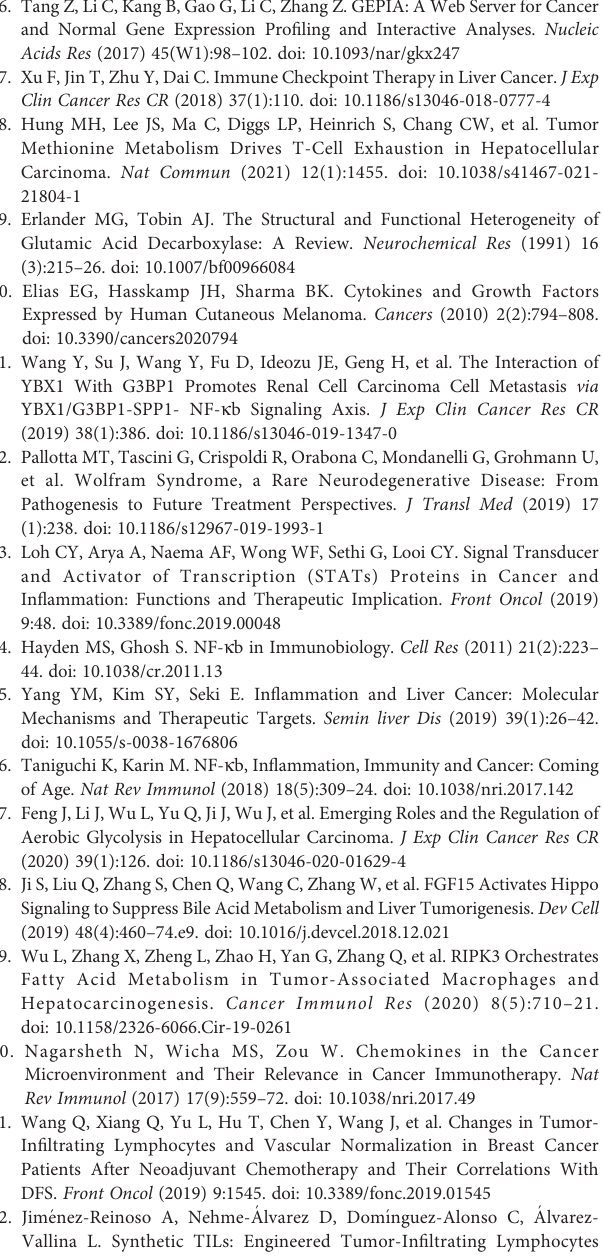
Supplementary Figure 1 | Comparison of WFS1 and EHHADH response to immunophenoscore treatment. (A) IPS, IPS- CTLA4, IPS- PD1/PDL1/PDL2, and IPS- PD1 PD1/PDL1/PDL2+CTLA4 in WFS1 signature high- risk group and low- risk group. (B) IPS, IPS- CTLA4, IPS- PD1/PDL1/PDL2, and IPS- PD1 PD1/PDL1/ PDL2+CTLA4 in EHHADH signature high- risk group and low- risk